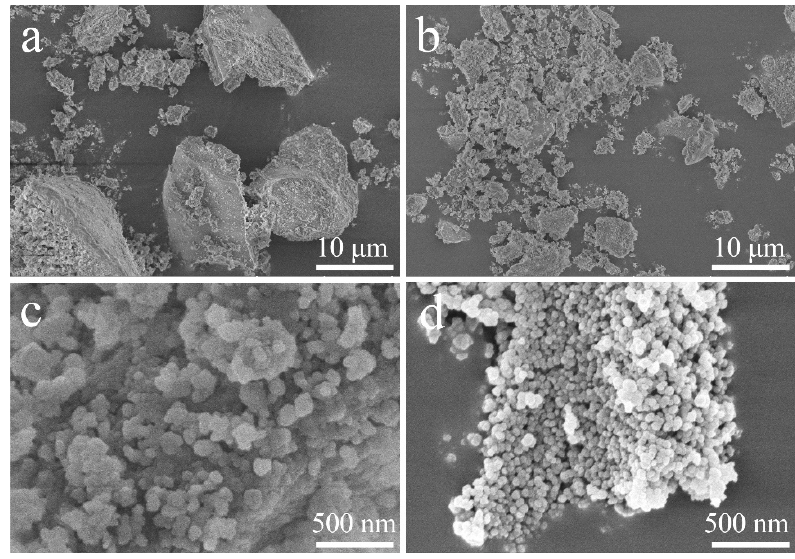
Figure 2. SEM images of WRHA ( a , c ) and ARHA ( b , d ) at different magnifications.